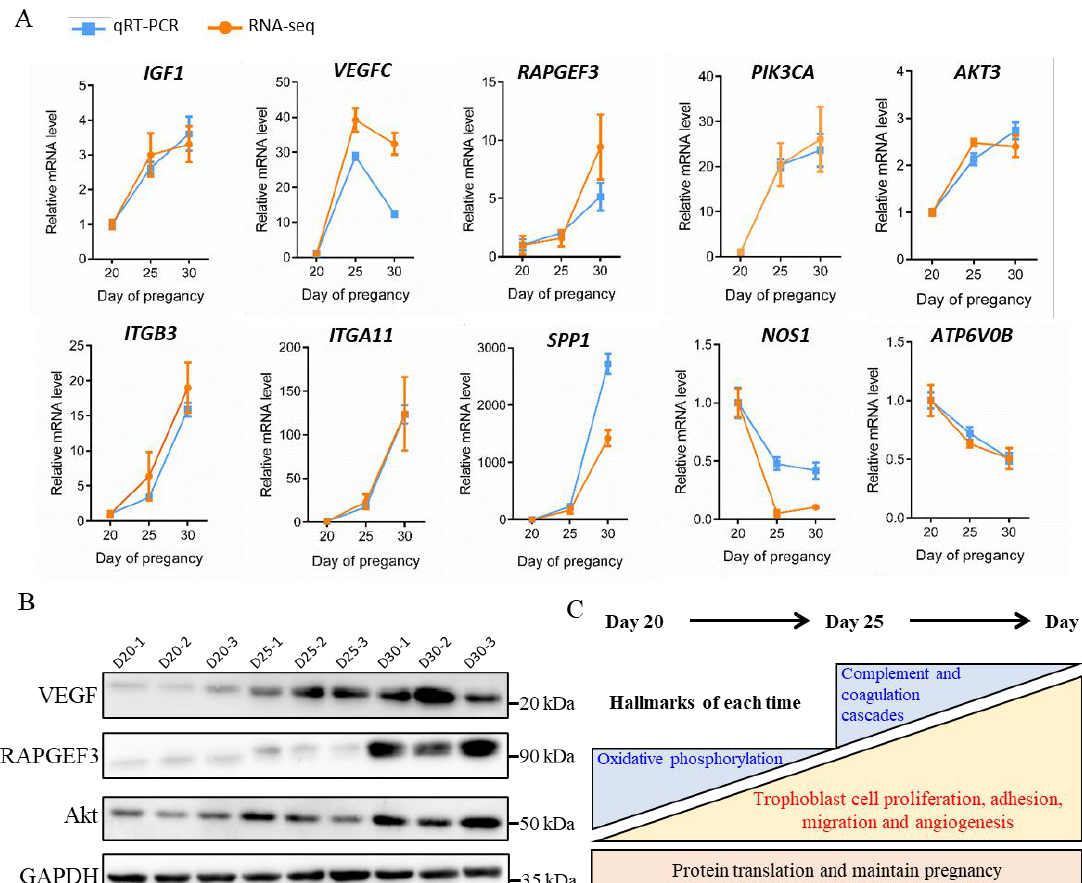
Figure 6. Validation of DEGs expression and summary of physiological processes at early placenta development in goats. ( A ). Comparison of gene expression levels between RNA-Seq and qRT-PCR in trophoblast at 20, 25, and 30 days of pregnancy. ( B ). Western blot showing the translational expression level of candidate genes (VEGF, RAPGEF3, and Akt) in trophoblast at 20, 25, and 30 days of pregnancy. ( C ). Summary diagram showing the functional annotations for ChEGs and DEGs in trophoblast by the time of placenta development.